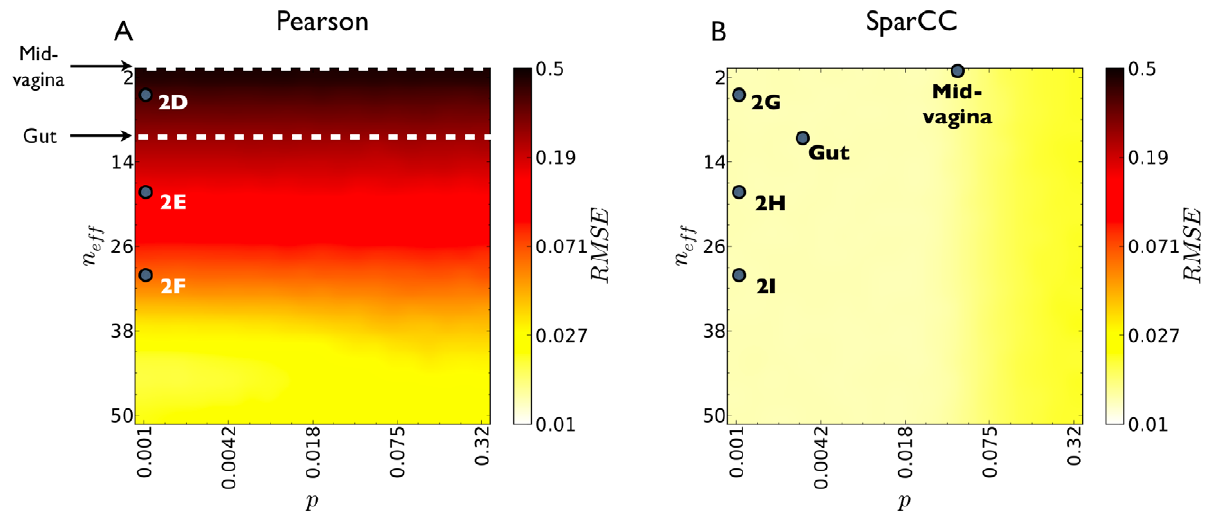
Figure 3. SparCC outperforms standard inference. Root-mean-square error (RMSE) of both Pearson (A) and SparCC (B) inferred correlations, as a function of the density of the underlying correlation network, as given by the probability that any pair of components be strongly correlated p , and community diversity, as given by the Shannon entropy effective number of components n eff . SparCC errors are smaller than Pearson errors for all parameter values. For the maximal diversity plotted, 50 effective OTU, the inference error obtained using Pearson correlations is greatly decreased. Therefore, it is likely that Pearson correlations perform well on gene expression data, where the effective number of genes is typically in the hundreds or thousands. For each combination of density and diversity, multiple basis correlation networks were randomly generated, and corresponding data was sampled and used for correlation estimation. Dots labeled mid-vagina and gut indicate the average diversity observed in the mid-vagina and gut communities, and the density of their estimated correlation networks. Dots labeled 2D–I indicate the diversity and density used to generate the communities analyzed in Fig. 2.